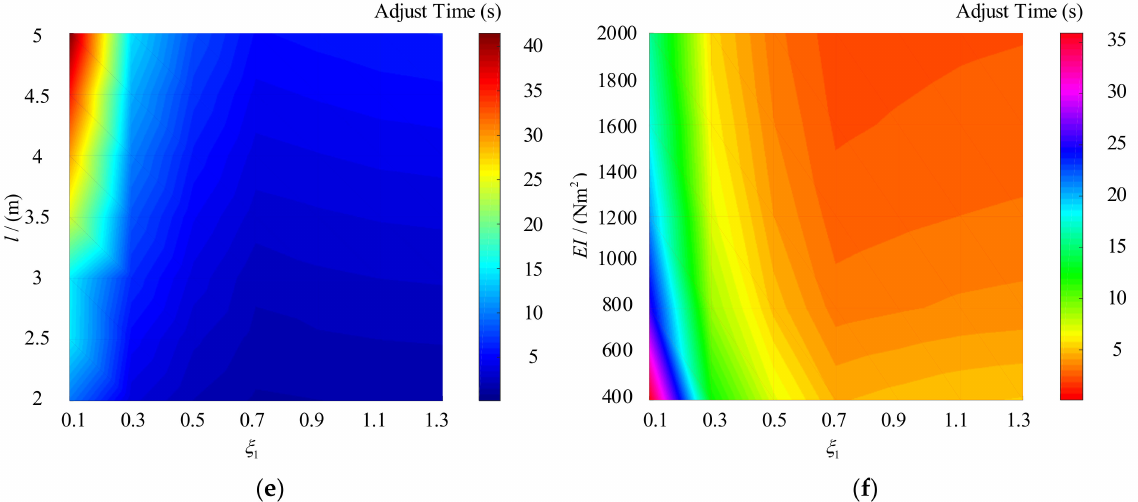
Figure 11. Distribution diagram of evaluation index. ( a ) The influence of length and the damping coefficient of poles on the maximum overshoot. ( b ) The influence of elastic modulus and the damping coefficient of poles on the maximum overshoot. ( c ) The influence of length and the damping coefficient of poles on the peak time. ( d ) The influence of elastic modulus and the damping coefficient of poles on peak time. ( e ) The influence of length and the damping coefficient of poles on adjustment time. ( f ) The influence of elastic modulus and the damping coefficient of poles on adjustment